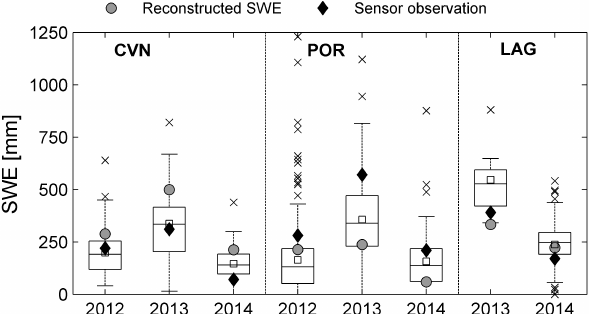
Figure 3. Reconstructed SWE validation at selected snow-pillow sites. Black diamonds are instrumental records, gray circles are model estimates, and box plots summarize the manual verification data set around the pillow site. Upper and lower box limits are the 75 and 25% quartiles, the horizontal line is the median, the white box is the mean, upper and lower dashes represent plus and minus 2.5SD from the mean, and crosses are outlying